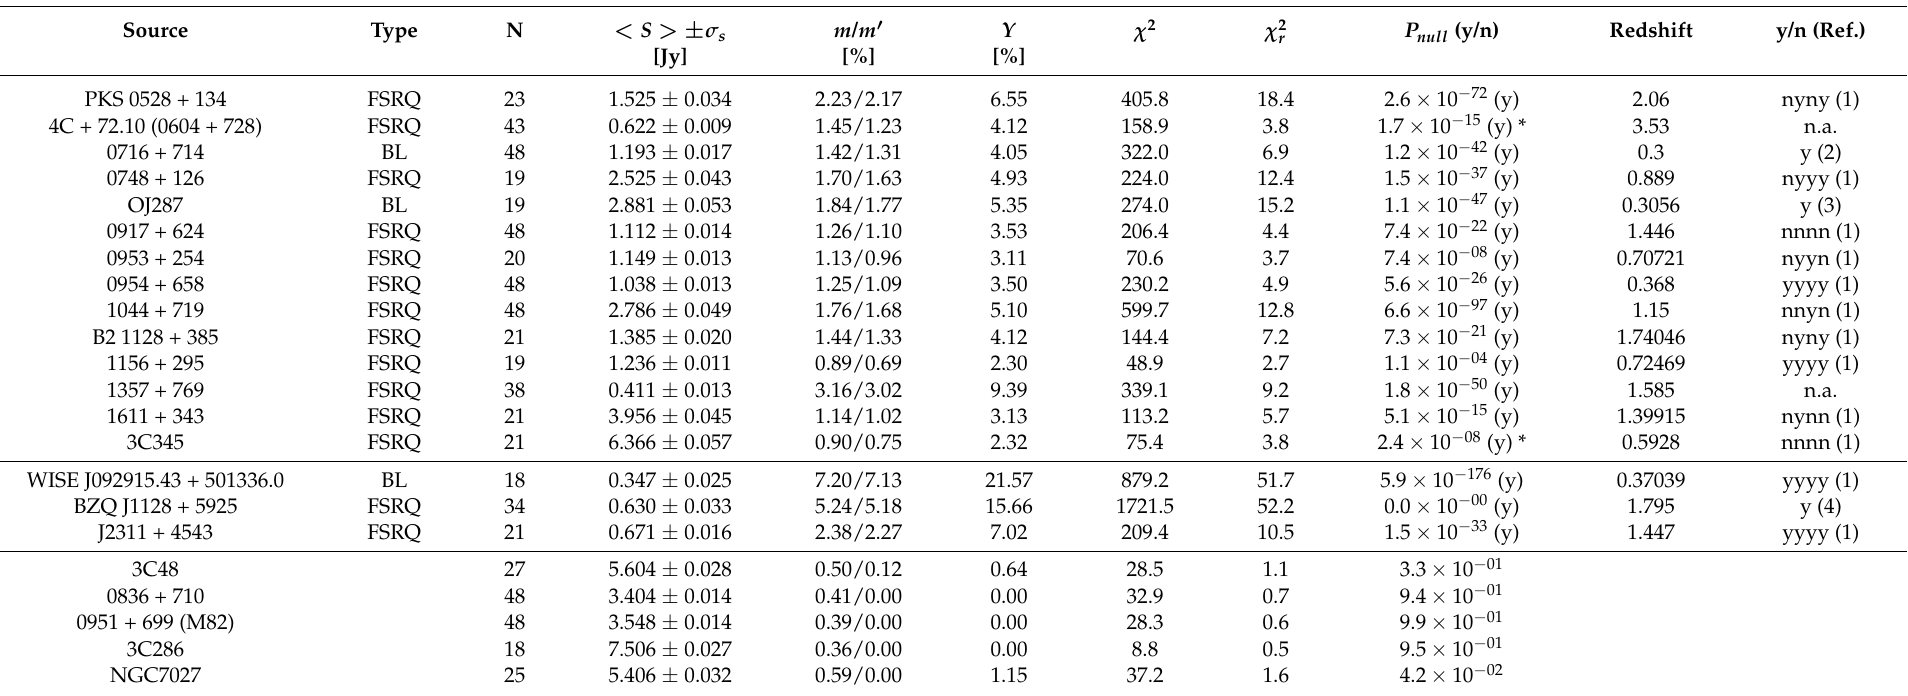
Table 2. The result of the IDV observation in 7–9 March 2014 with Urumqi 25 m telescope at 4.8 GHz. The columns are same as that in Table 1. The * marked in Column 9 indicates new IDVs found from this